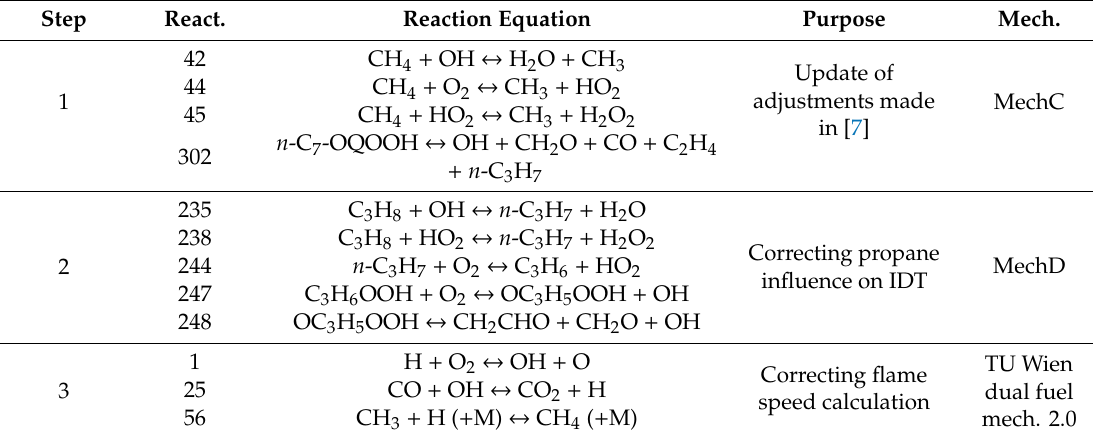
Table 5. Overview of the reactions used for the mechanism adaption, the purpose of the adaptation and the resulting